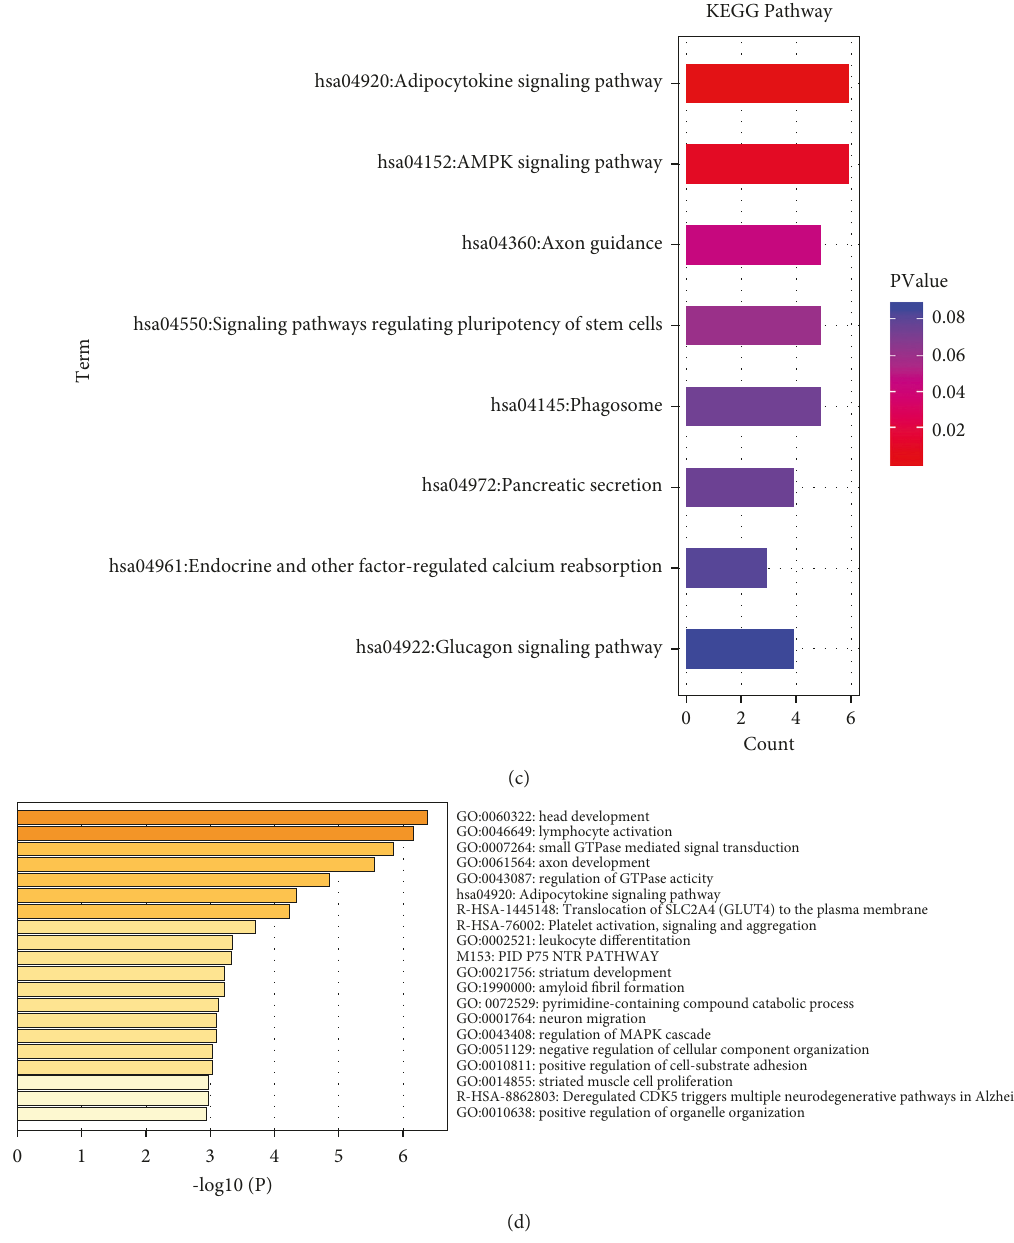
Figure 3: Functional enrichment analysis via DAVID and Metascape database. GO analysis was performed on the target genes of the DEmis, and the most significantly enriched biological process terms (a) and the molecular function terms (b) were presented as bar graphs. KEGG signaling pathways enriched from the target genes of the DEmis (c). The enriched functional terms enriched from target genes of the DEmis were determined by Metascape online analytics tool based on several databases such as GO, KEGG, Reactome, and CORUM. The top 20 enriched terms were visualized as an enrichment bar graph (d).